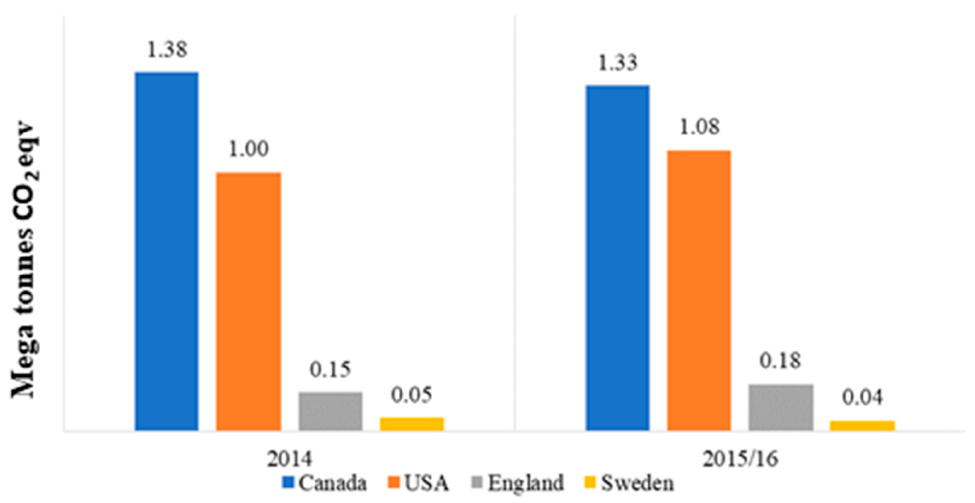
Figure 1. Reduction in carbon footprint via